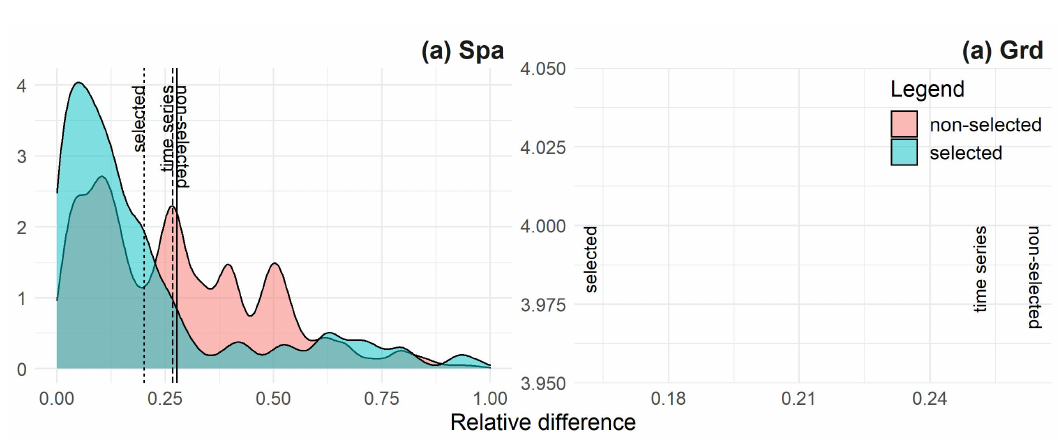
Figure 5. The density of relative errors in Spa ( a ) and Grd ( b ) based on selected best-performing OFs (green area) and the rest (red area). The dotted line correspond to the mean of the selected best-performing objective functions, the dashed line to the mean OFs, including time series, and the solid line to the mean of the OFs that were not